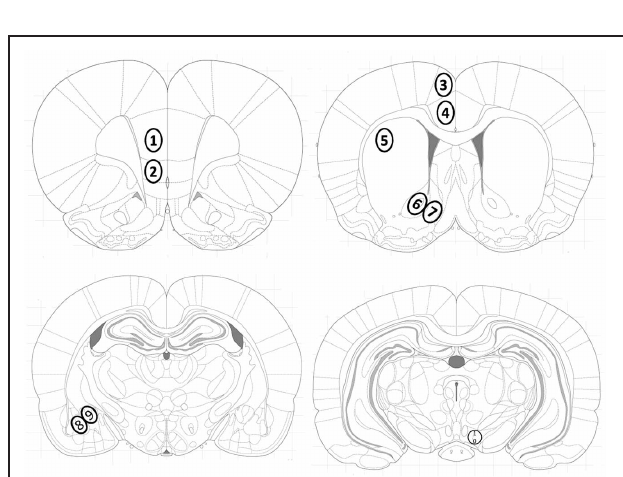
FIGURE 5 | Location of investigated brain areas. Brain areas were identified according to the atlas of Paxinos and Watson (Paxinos and Watson, 2007): the (1) prelimbic (PrL) and (2) infralimbic (IL) cortex, the cingulate cortex areas (3) Cg1 and (4) Cg2, (5) dorsolateral striatum (caudate putamen, CPu), the (6) nucleus accumbens core (AcbC) and (7) shell (AcbSh) subregions, (8) basolateral (BLA) and (9) central (Ce) amygdala, and (10) the ventral tegmental area